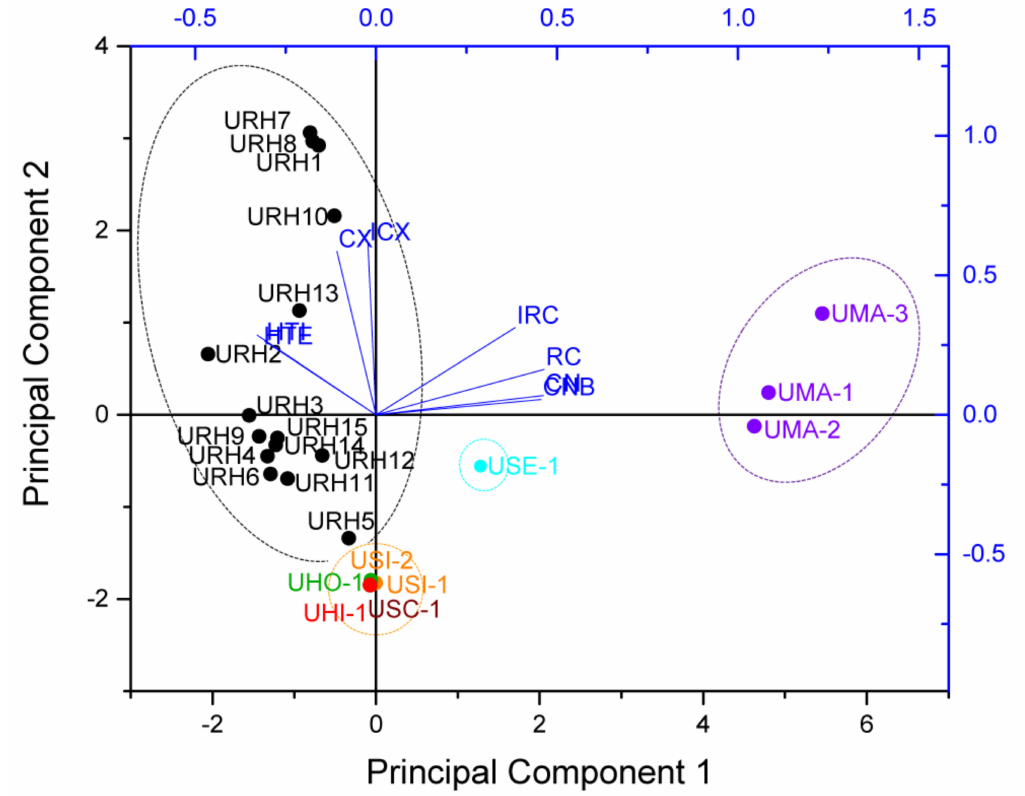
Figure 4. The score plot and loading plot of PCA for different Uncaria